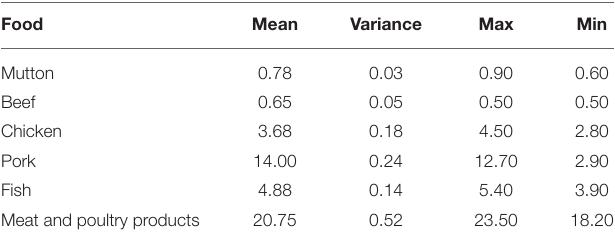
TABLE 10 | Meat consumption quantity of Chinese rural residents (average values from 2000 to 2012)